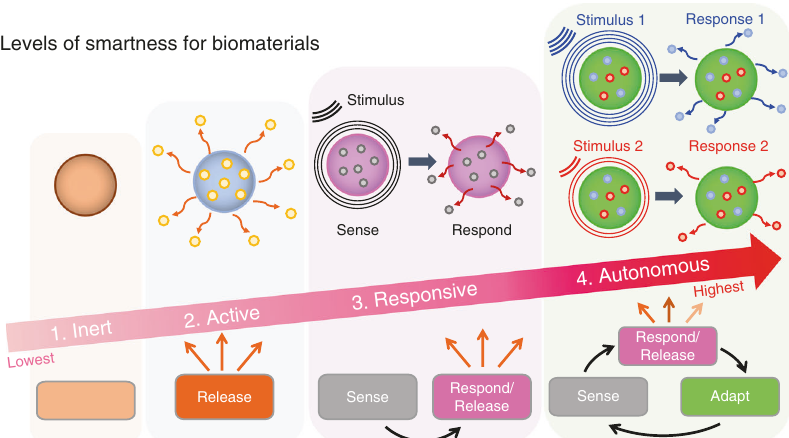
Fig. 1 The four increasing levels of smartness for biomaterials include inert, active, responsive, and autonomous. Inert biomaterials offer “ merely ” biocompatibility and do no harm, i.e., no toxic reaction in/to the body. Active biomaterials offer a one-way, uncontrolled release of therapeutics. Responsive biomaterials can sense speci fi c signals found in the environment or biological processes to then release therapeutics. Autonomous biomaterials can sense a signal, release a speci fi c payload, and adapt their properties to changing conditions to keep providing additional, advanced, and/or alternative forms of therapeutics